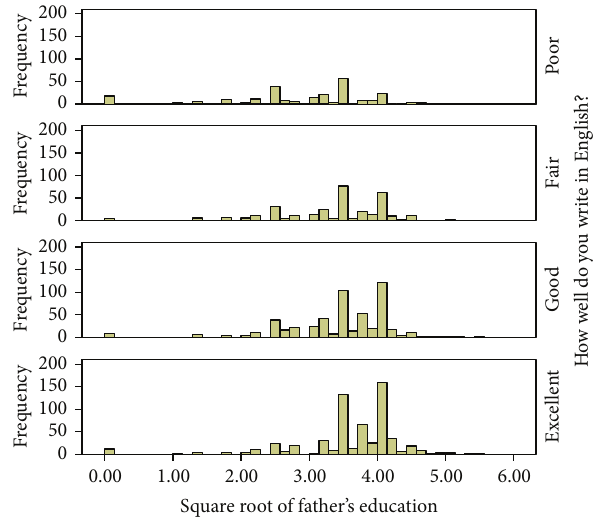
Figure 5: Histograms of raw data of the square root of father’s education by writing proficiency in